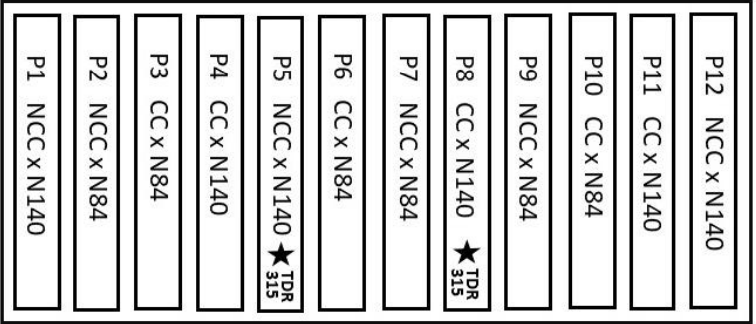
Figure 1. Experimental plot layout with RCBD; Block 1 (P1–P4); Block 2 (P5–P8); Block 3 (P9–P12). Soil water sensing devices (TDR-315) were installed in P5 and P8 for measuring soil volumetric water content. Associated with each soil water sensing system in P5 and P8, four soil water sensors (TDR 315) were installed at depths of 15, 30, 46, and 61 cm.